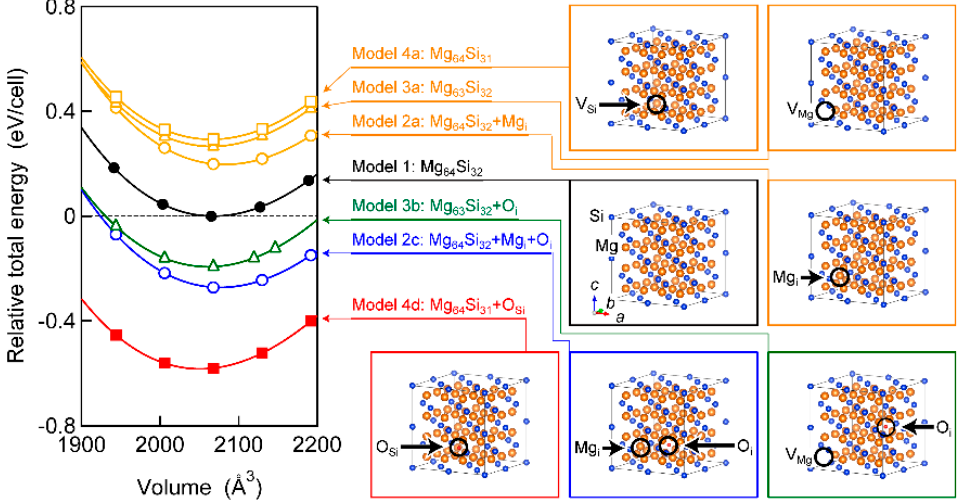
Figure 1. Volume dependence of the total energy of seven crystal structure models relative to the minimum energy of Model 1. Crystal structures were drawn using VESTA [66].